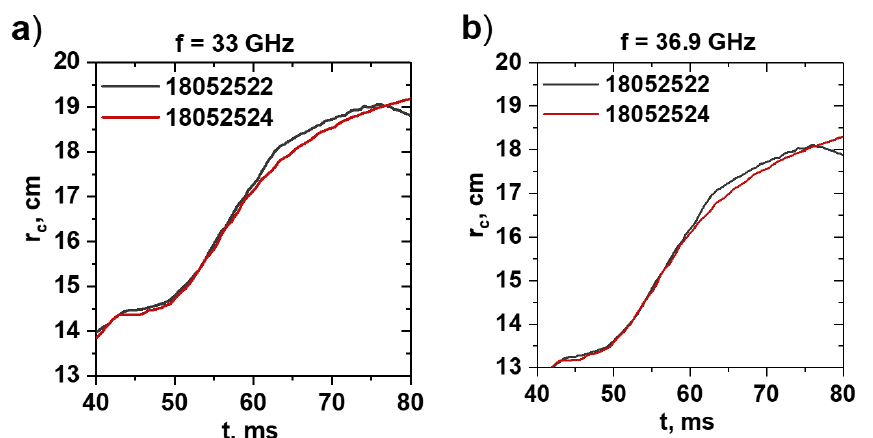
Figure 6. Temporal evolution of the cut-off radius for the probing beams of the DBS diagnostic ( a ) for the 33 GHz probing frequency, ( b ) for the 36.9 GHZ probing frequency.